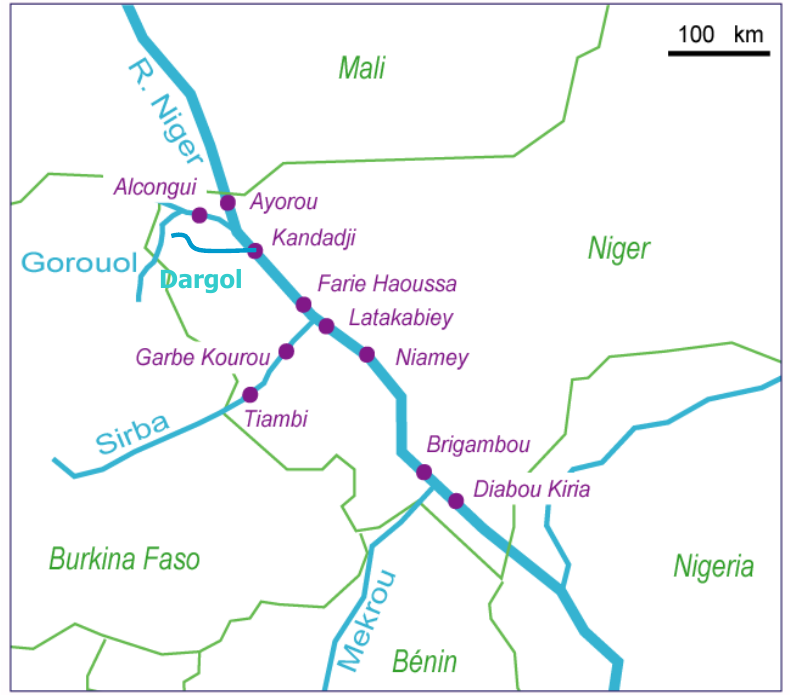
Figure 3. Map of Niger River middle reach and its main tributaries. Location of tributaries and stream gauges stations of Kandadji and Niamey is